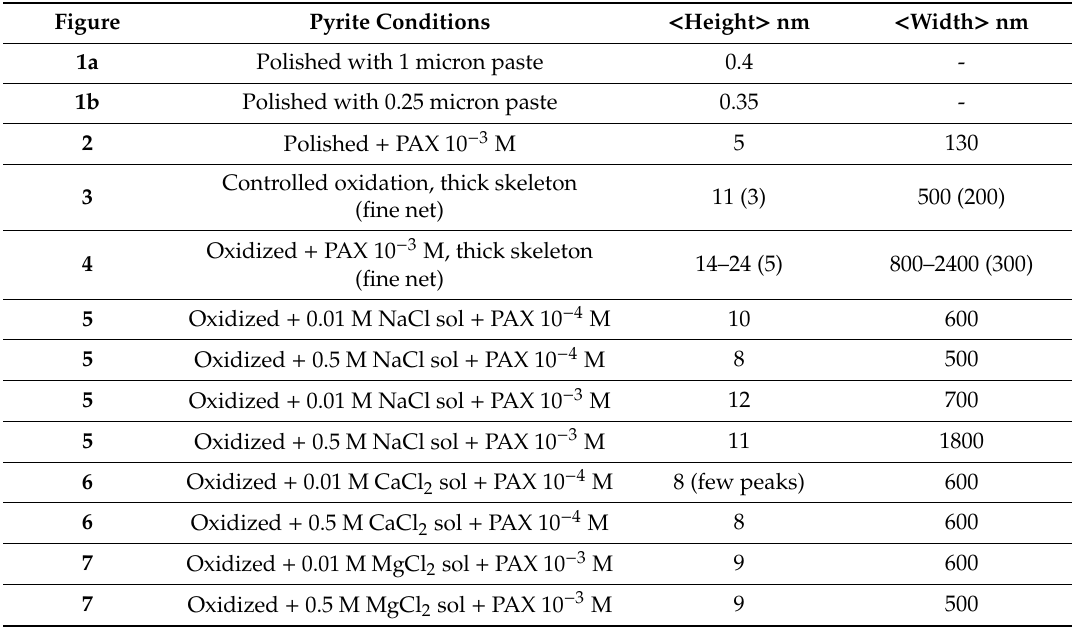
Table 1. Summary of average height / width of the di ff erent peaks for pyrite at di ff erent conditions. Figure Pyrite Conditions < Height > nm < Width > nm 1a Polished with 1 micron paste 0.4 - 1b Polished with 0.25 micron paste 0.35 - Polished + PAX 10 − 3 M 130